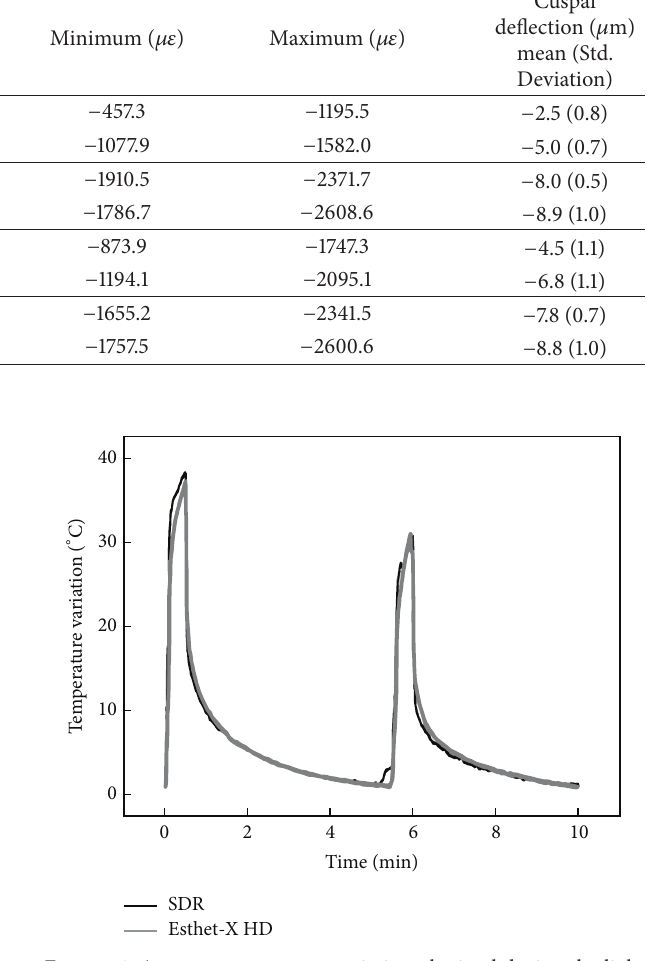
Figure 4: Average temperature variation obtained during the light curing of the restorations with the SDR (cid:3) and Esthet ∙ X (cid:2) HD resins.